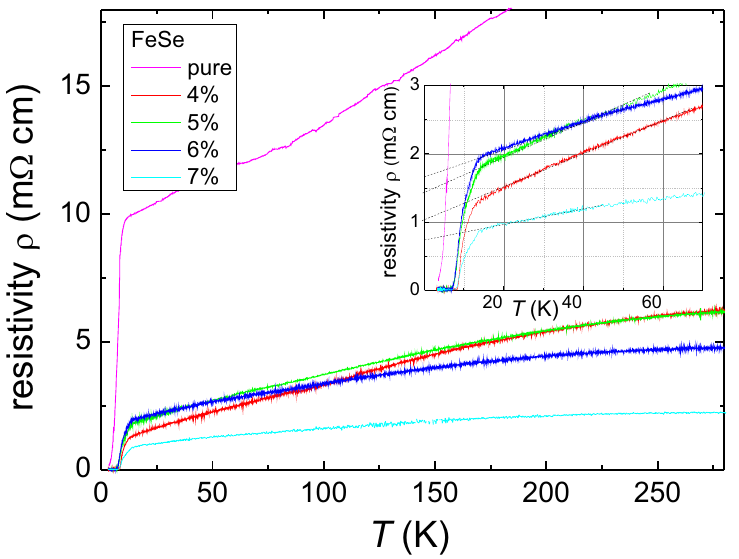
Figure 4. Resistivity measurement on the pure FeSe sample and on the Ag-containing FeSe samples in zero applied magnetic field. The Ag addition reduces the measured resistivity and also affects the superconducting transition. The inset reveals an enlarged view close to the superconducting transition and the determination of the residual